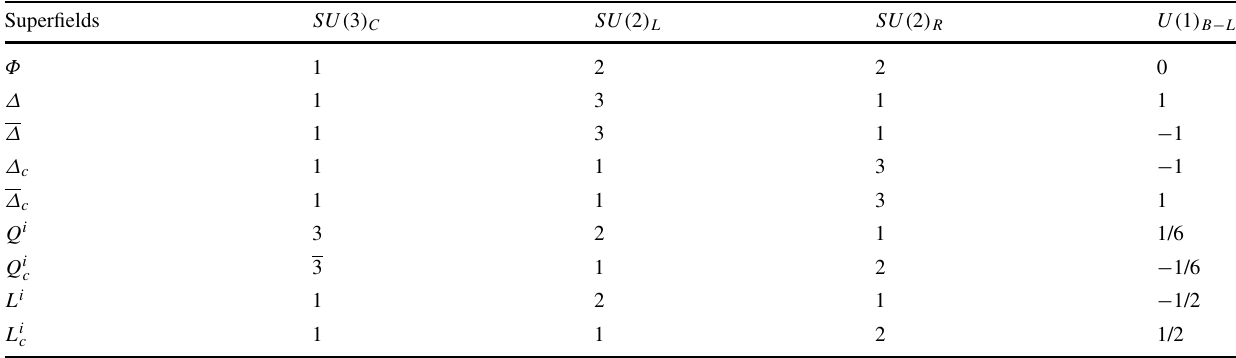
Table 55 Minimal supersymmetric left right model: quantum numbers of superfields under the gauge groups. Internal symmetry indices have been suppressed. i =1,2,...,